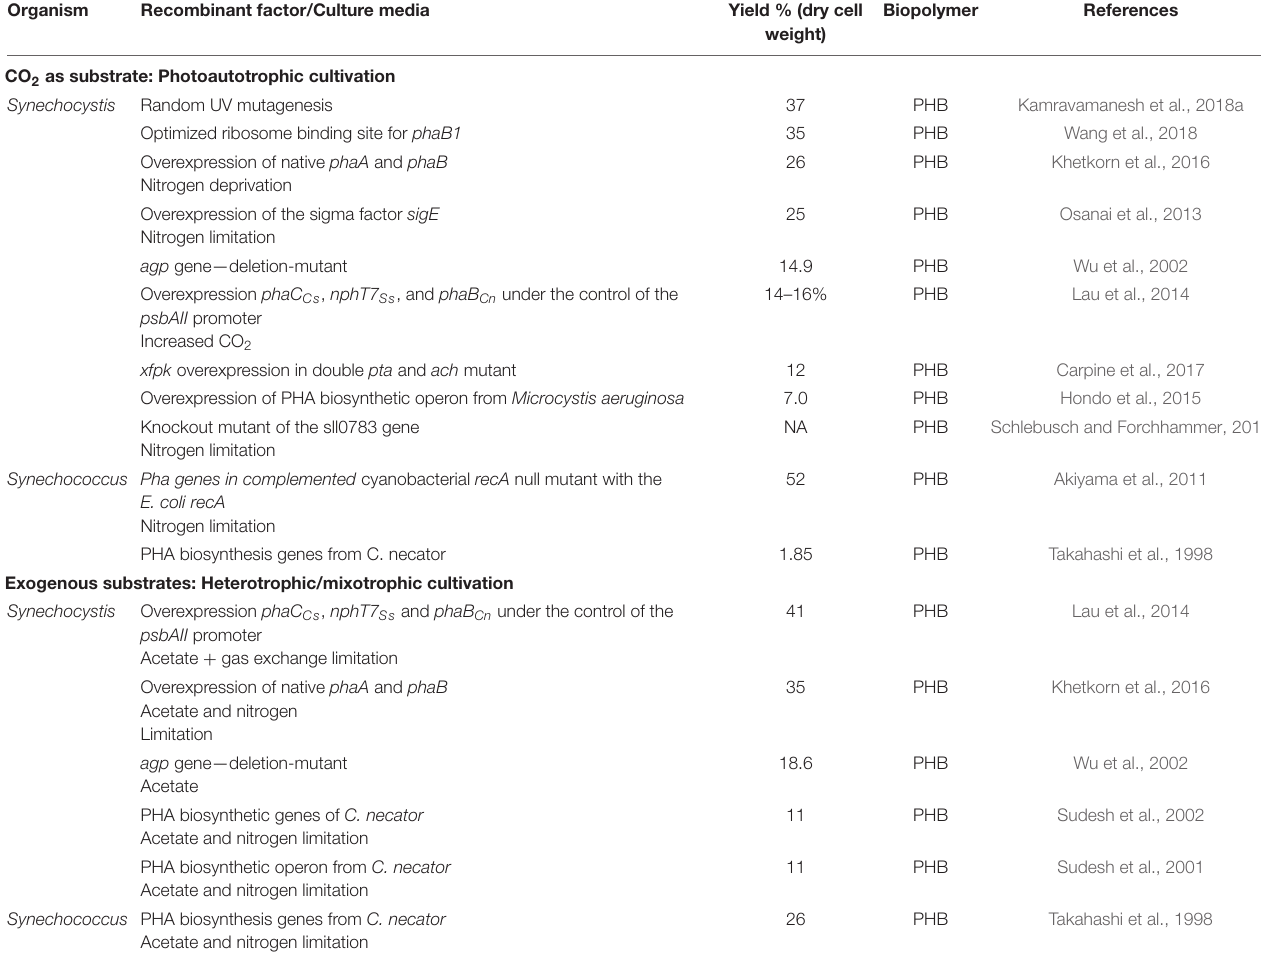
TABLE 3 | PHA production from recombinant cyanobacteria under different cultivation